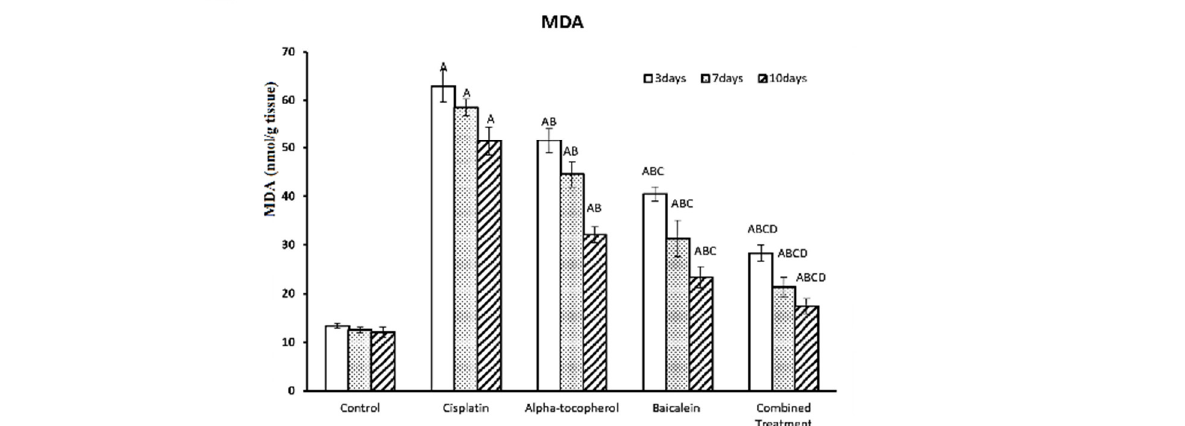
Figure 3. Effect of α -tocopherol and baicalein administration on SOD, GSH, and MDA levels in control and cisplatin-treated groups. All data are expressed as mean ± SEM. Significant vs. control group refers to A, while significant vs. (cisplatin, -tocopherol, and baicalein) treatment groups refers to (B, C, D), respectively.